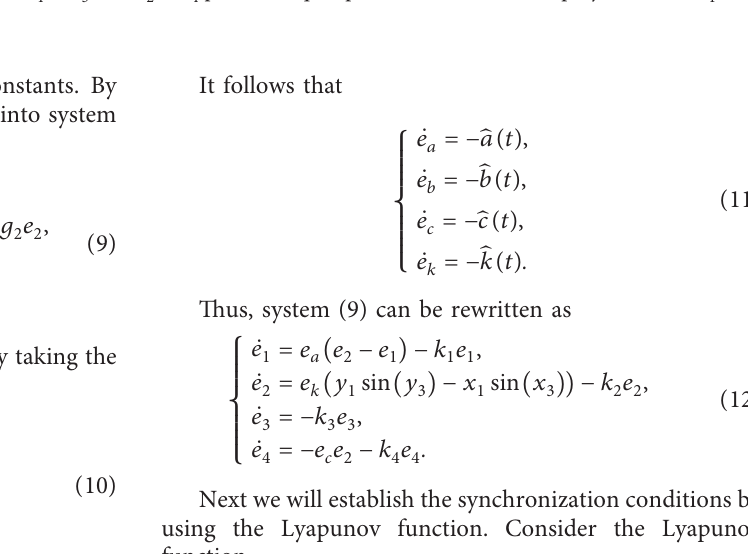
− x − x and x planes for quasiperiodic attractor; (e, f) projections on x 1 3 2 4